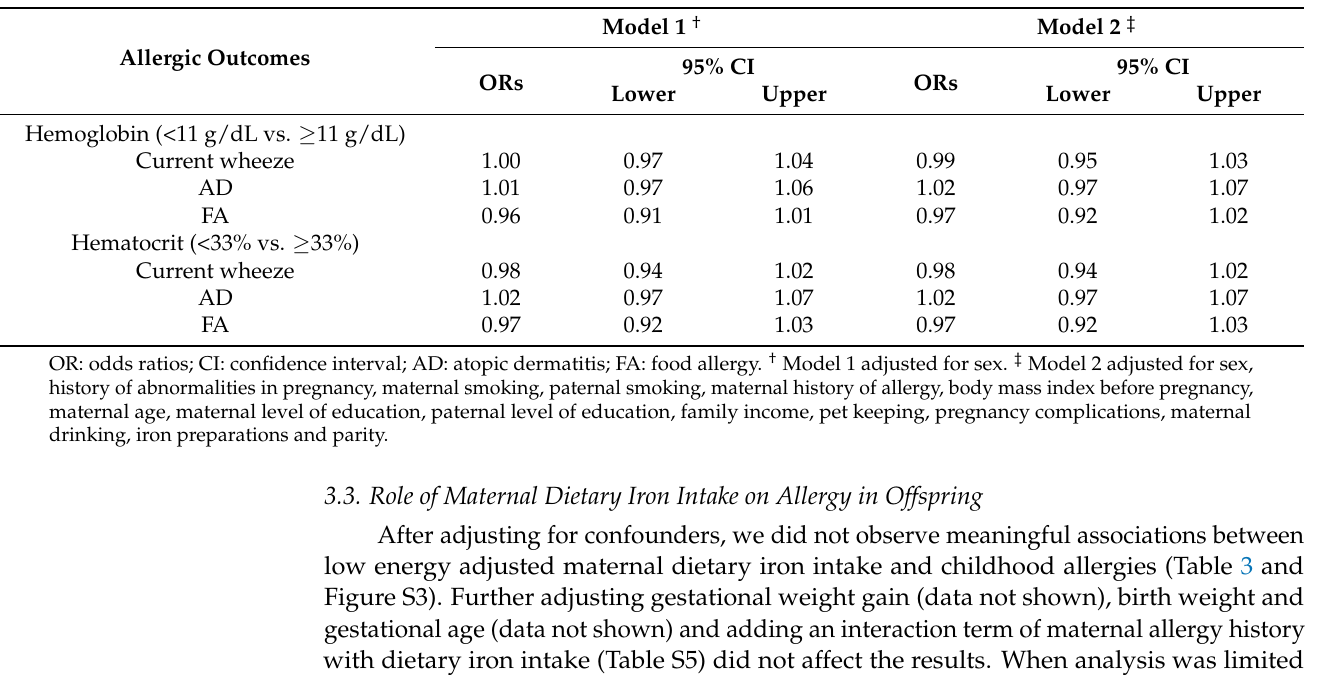
Table 2. Odds ratios from generalized estimating equation models evaluating the association of hemoglobin/hematocrit concentrations in pregnancy with wheeze, atopic dermatitis and food allergy in children.